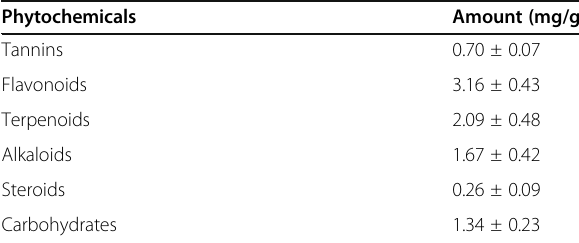
Table 1 Phytochemical constituent of JTME Phytochemicals